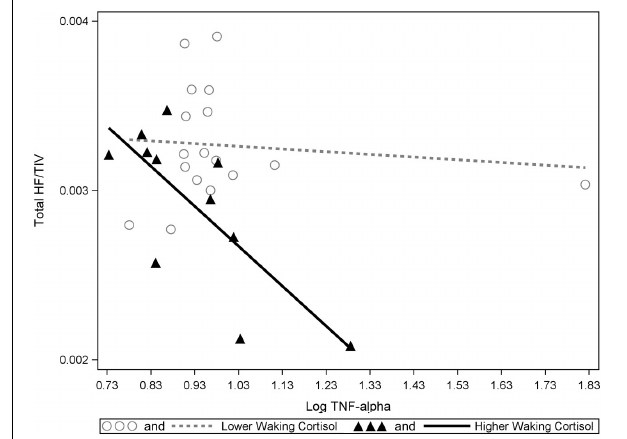
FIGURE 1 | Significant main effects and interactions between cytokines, waking cortisol, and hippocampal volume.